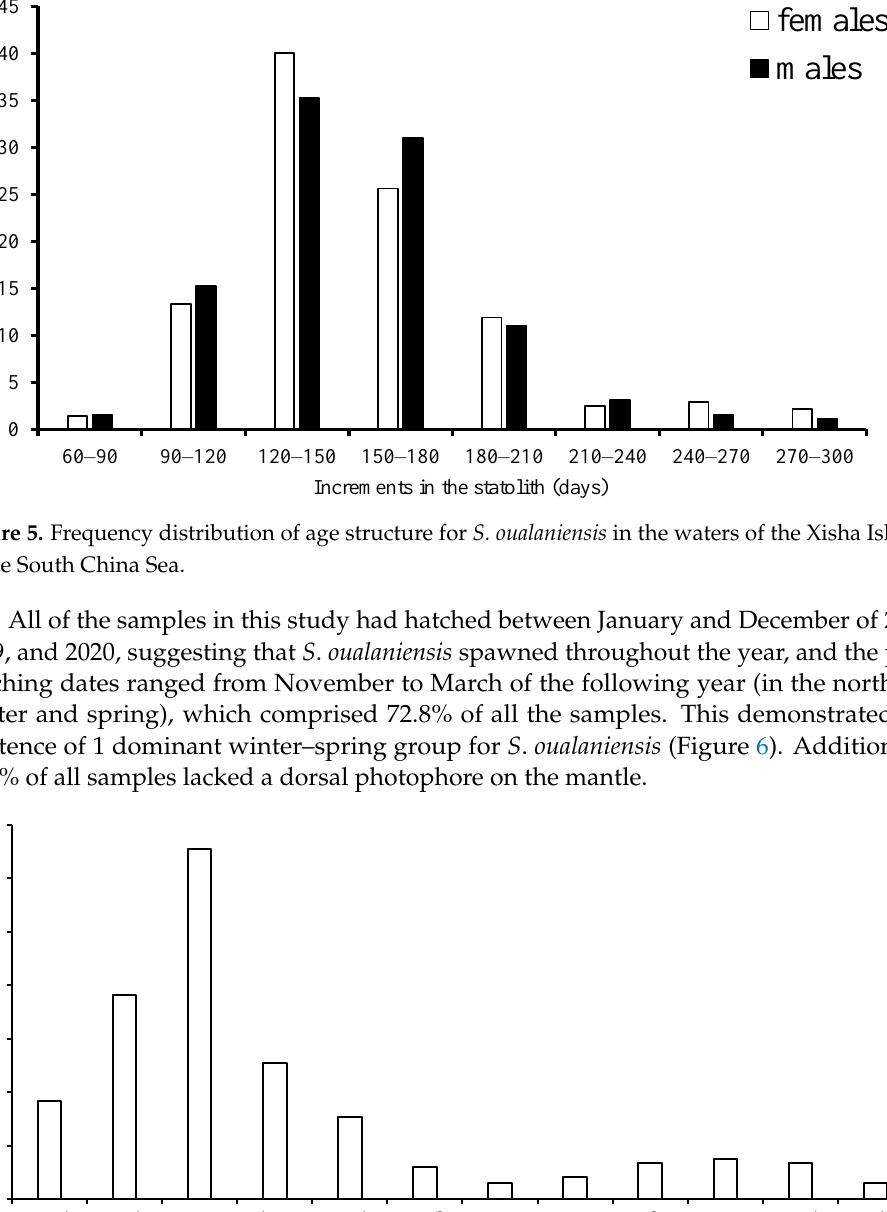
Figure 6. Frequency distribution of back-calculated hatching dates for S. oualaniensis in the waters of the Xisha Islands of the South China Sea.